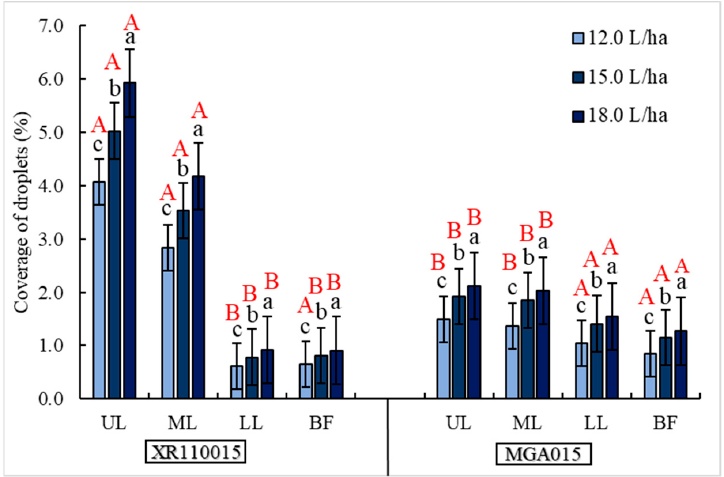
Figure 6. Droplet coverage (%) in the different collection positions: upper layer (UL), middle layer (ML), lower layer (LL), and bunch of fruit (BF) of papaya. Distinct letters: lower case differ among the application rates and upper case differ among the spray nozzles in the respective collection layers, Tukey’s test at p ≤ 0.05.